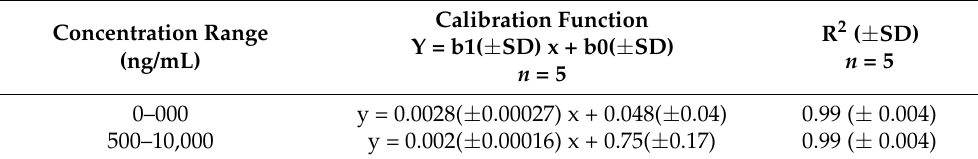
Table 1. Concentration ranges, calculated calibration functions and correlation coefficients (R 2 ). b1 and b0 are mean values ( n = 5).